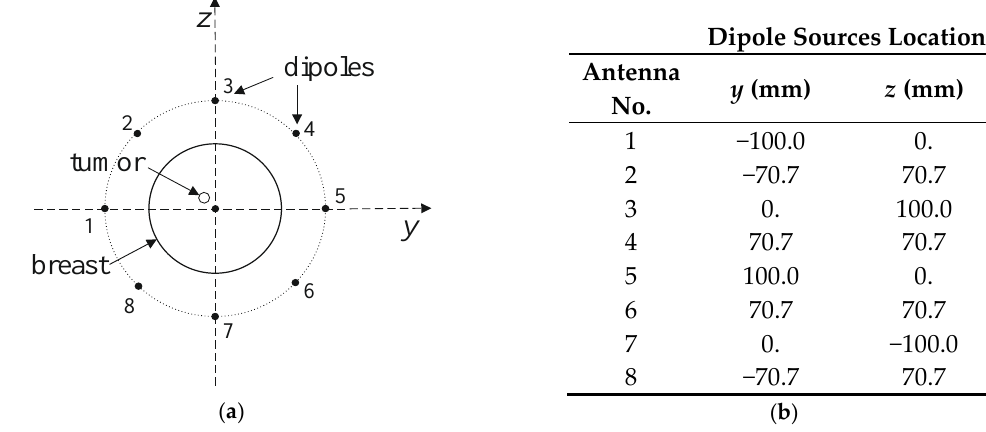
Figure 15. Arrangement of dipole antennas around the breast with a tumor of radius r = 2 mm centered at (0, −12,12) mm: ( a ): schematic sectional view; ( b ): dipole sources positions at x = 0 plane (antenna array radius R = 100 mm).